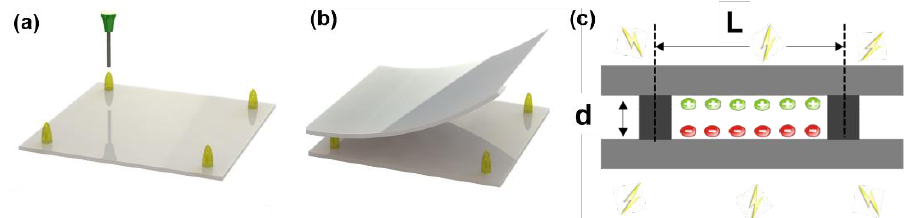
Figure 2. Schematic of micropillar based piezoelectret fabrication ( a ). Deposition of SU-8 epoxy resin by 3D printing machine in xyz-axis ( b ). Assembly of the micropillar structure with COC film by UV-curing the SU-8 epoxy resin ( c ). The 2D schematic view of the cross section of prepared piezoelectret with artificial charge voids inside. The micropillar structure were rendered piezoelectric by charging.